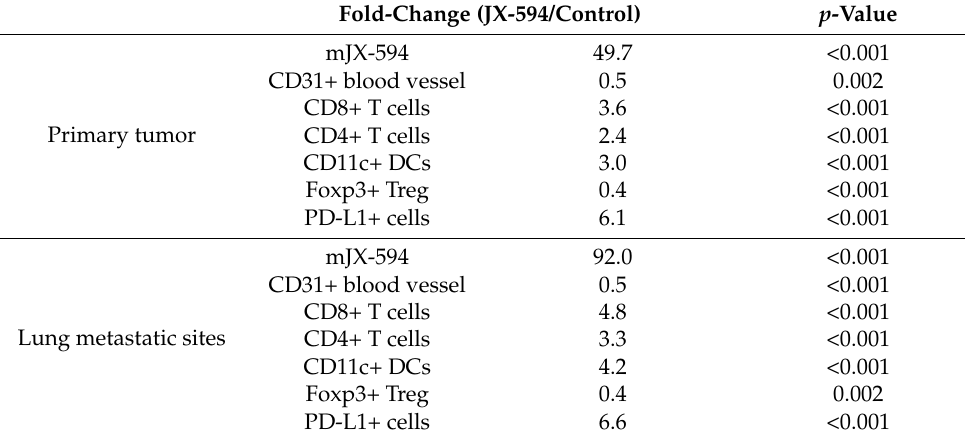
Table 2. Comparison of therapeutic efficacy of JX-594 monotherapy in advanced-stage metastatic renal cell carcinoma